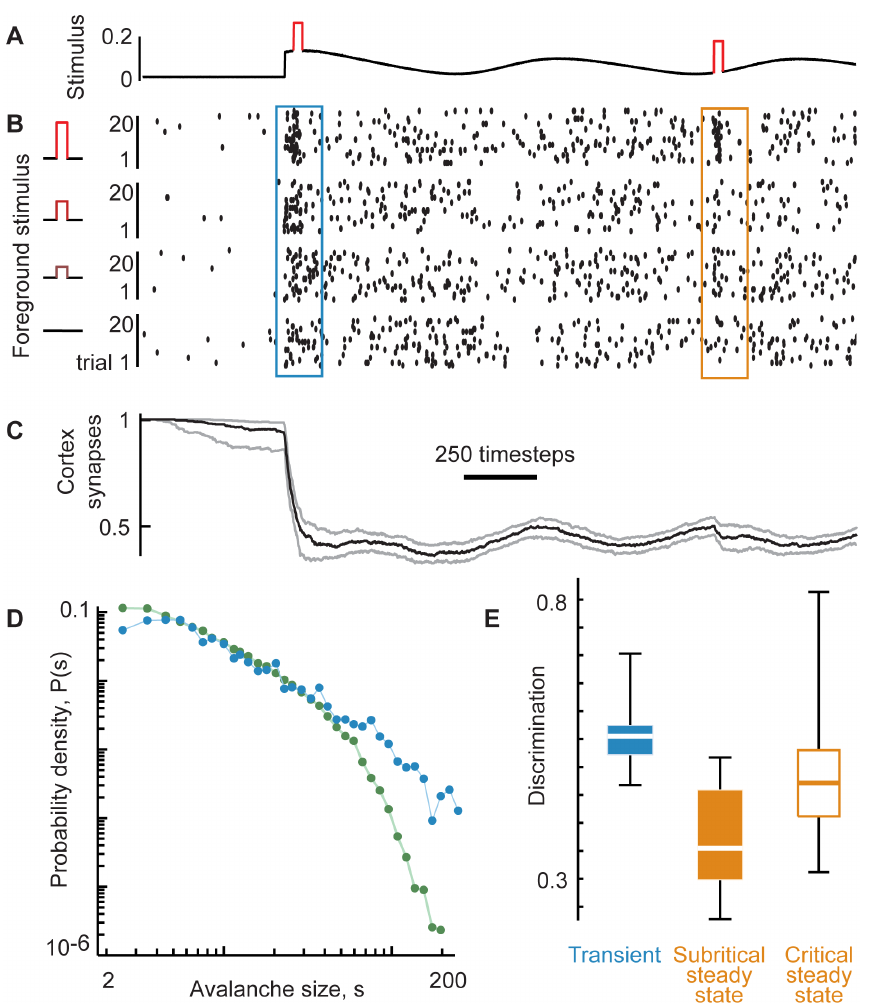
Fig 7. Extreme synaptic depression results in small-scale dynamics and decreaseddiscrimination. ( A ) Shownare results from our model with more extreme depression with τ d decreasedby a factor of 100 comparedto the model results in Fig 6. All other model parameters includingthe stimulus paradigmare unchanged. ( B ) Subsampled spike rasters for 20 trials for each of 4 different foregroundstimulus levels. Note that the steady state spike rate is lower than that in the model results of Fig 6. Spike response does not vary strongly with changingforegroundduringthe steady state. ( C ) The extreme depressionimplemented here results in about 50% reduction in cortex synapse strengths. This is a large reductioncomparedto the ~10% reduction for the model results in Fig 6. ( D ) During the baselineperiod (same definitionas shown in Fig 6), avalanchesizes are not distributed accordingto a power-law(green), indicating that the dynamics are not at criticality. Rather, the curvature of the distribution and the lack of large avalanches are consistent with subcriticaldynamics. In contrast, the avalanchesize distributionduringthe transient is close to a power-law becausethe synapses have not yet reacheda low enoughlevel to strongly deviatefrom criticality. ( E ) In contrast with the results in Fig 6, the transient period(blue) exhibits high discrimination as expectedfor critical dynamics. The subcriticalsteady state (solid, orange)exhibits decreased discrimination comparedwith the critical steady state of Fig 6 (open, orange).Box vertically spans the two quartilesaroundthe median(middle line). Whiskers indicatethe range of the